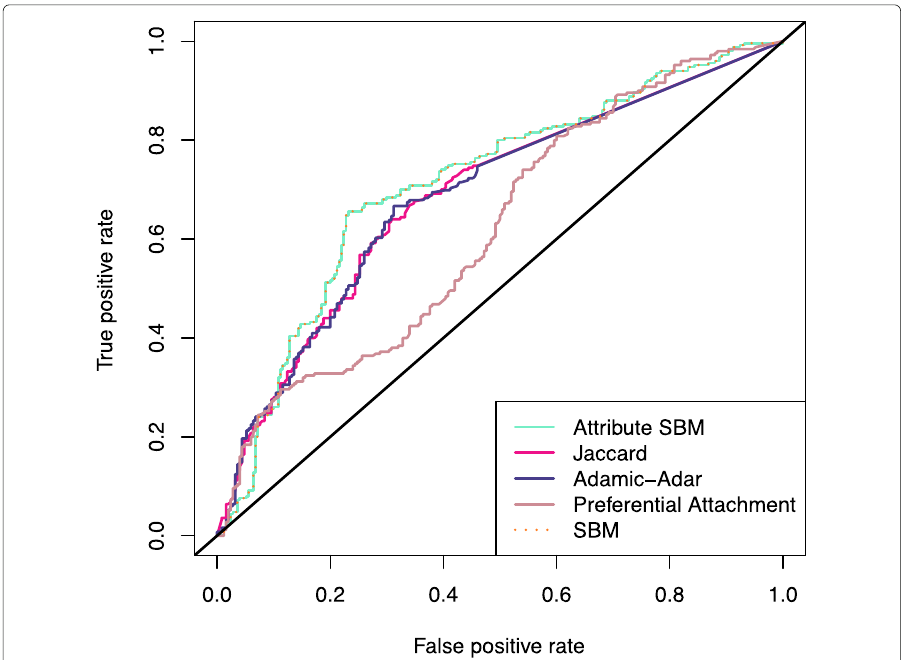
Fig. 4 Link Prediction on the microbiome subject similarity network: The results for link prediction on the microbiome subject similarity network for the attributed SBM, Jaccard, Adamic-Adar, preferential attachment, and SBM methods. The corresponding AUC values for these methods, respectively are, 0.71, 0.69, 0.69, and 0.62, and 0.71,